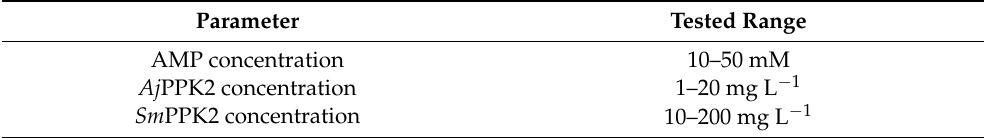
Table 1. Optimization parameters and their tested concentration window.